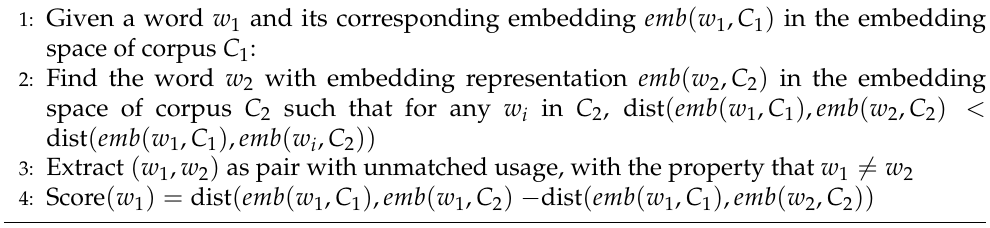
Algorithm 1 Detection of misaligned word pairs between two